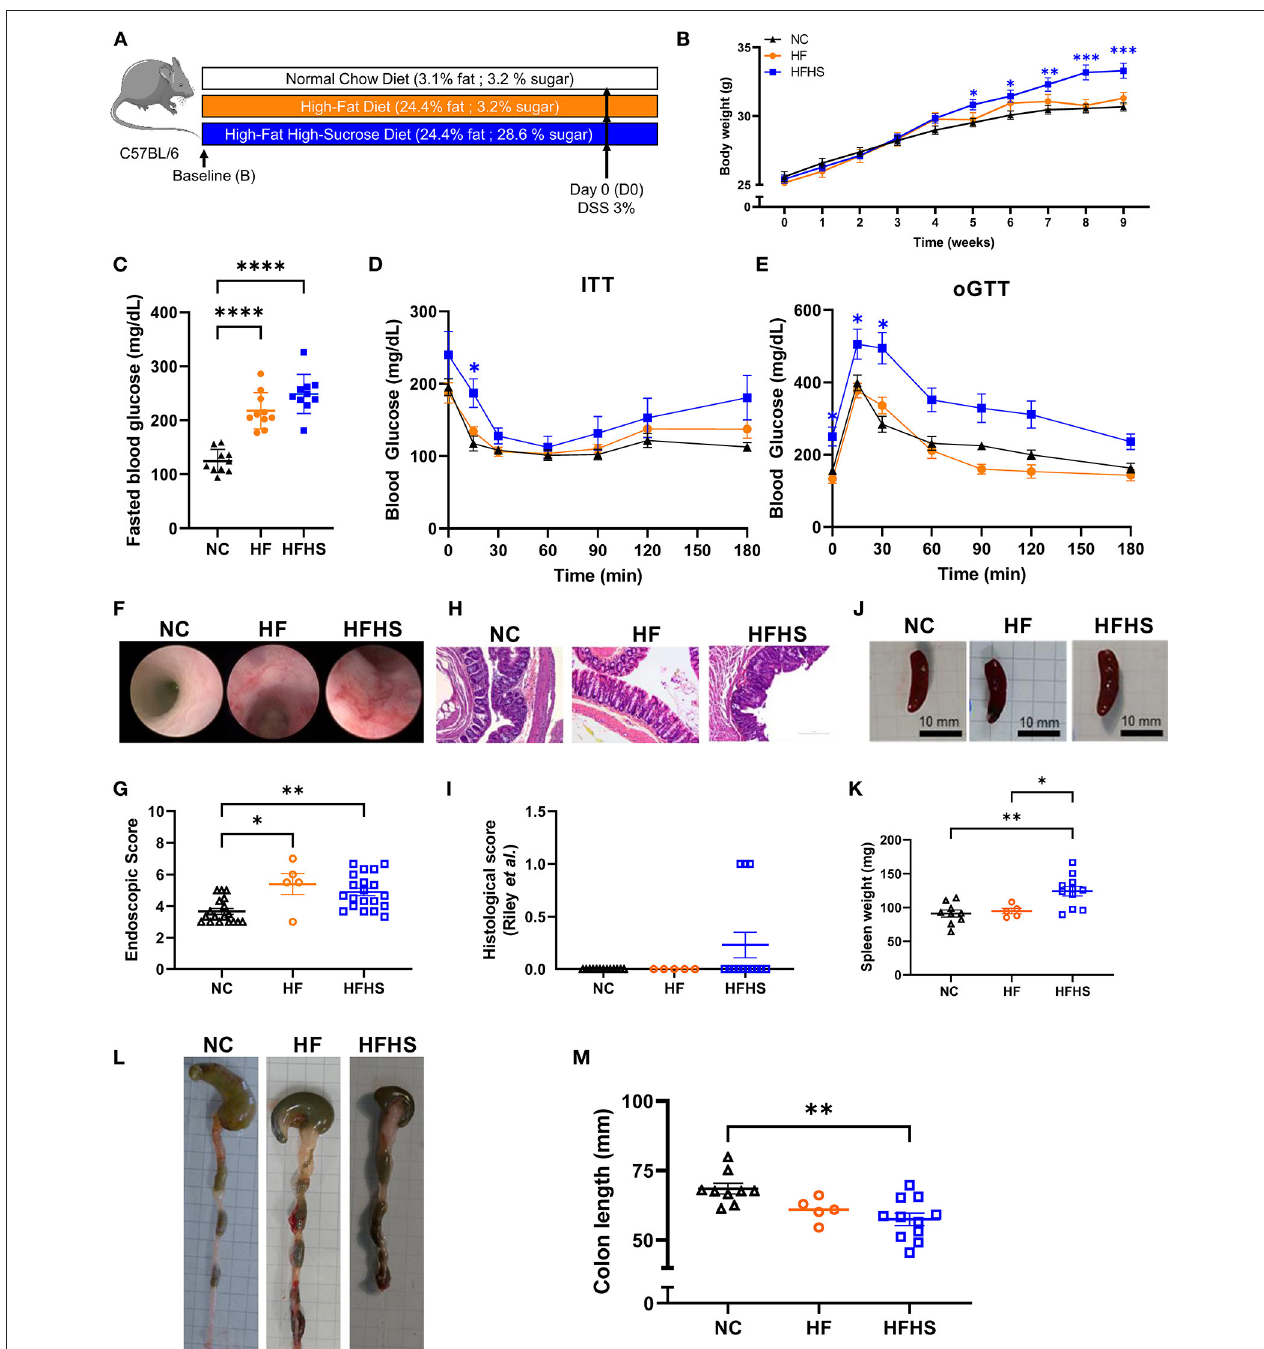
FIGURE 1 | Additive effects of sucrose and fat in healthy mice. (A) Experimental design. Mice were fed 8 weeks with normal chow diet (NC) or High-Fat (HF) diet or High-Fat High-Sucrose (HFHS). (B) Body weight of HSHF-fed mice ( N = 40) was higher than HF-fed mice ( N = 10) or NC-fed mice ( N = 36). (C) Fasting blood glucose levels in HFHS, HF and NC-fed mice ( N = 10 /group). (D) Insulin tolerance test (ITT) after 8 weeks of diet (0.75 U/kg insulin, ip). (E) Oral glucose tolerance test (oGGT) after 8 weeks of diet (2 g/kg per os) for HFHS, HF and NC-fed mice ( N = 5/group). (F) Representative colonoscopy images (G) Ulcerative colitis endoscopic index of severity (UCEIS) (H) Representative sections of colon, arrows show epithelial dystrophies. Scale bars, 0.10mm. (I) Histological scores. (J) Gross pictures of spleens, scale bars: 10mm. (K) Spleen weight to body weight ratio. (L) Gross pictures of colons. Scale bars, 10mm. (M) Colon lengths. Data are given as means + /- SEM. * p < 0.05, ** p < 0.01, *** p < 0.001, **** p < 0.0001 by ANOVA (two-way for B, D and E) for parametric data or Kruskal-Wallis if not.